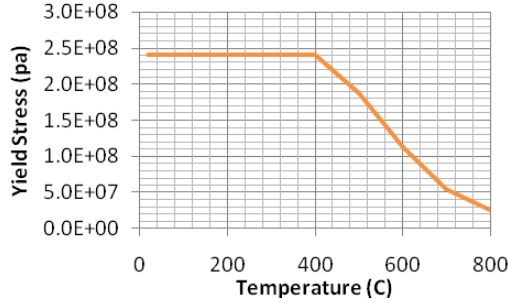
Fig. 4. Yield stress versus temperature.